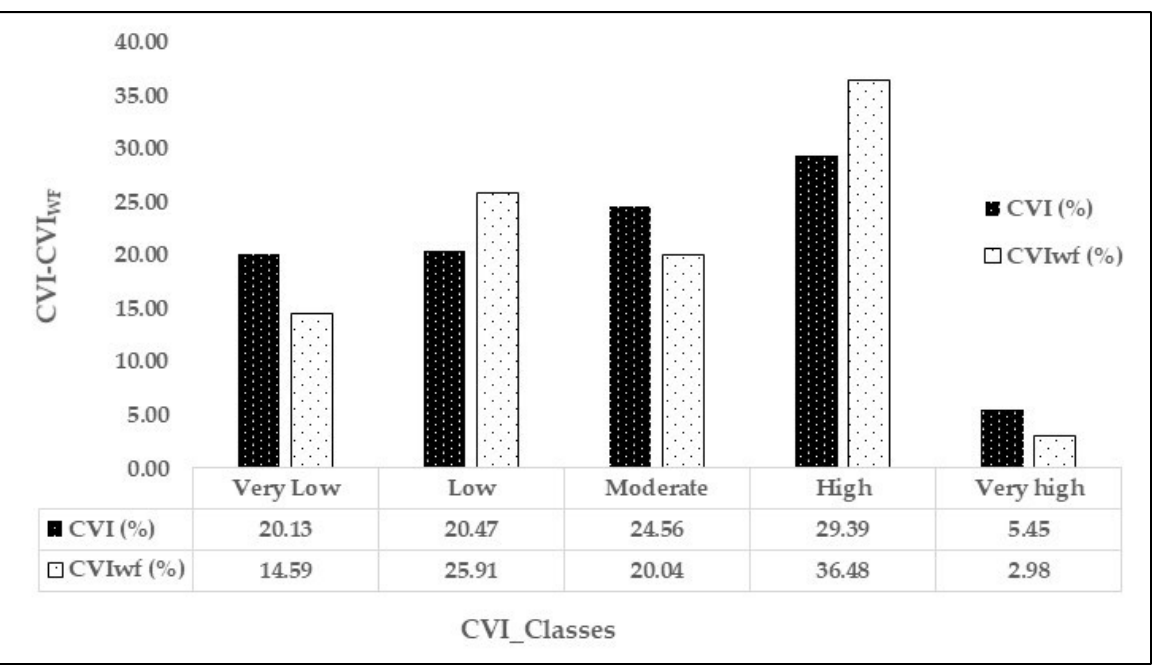
Figure 6. Comparison between the (CVI) and (CVI WF ) models applied in the research area. The results of the spatial analysis from the CVI model application revealed that the areas that have very low vulnerability at erosion are Zones 2 and 5, low vulnerability, 7 and 8. On the other hand, the results of the spatial analysis from the CVI WF model